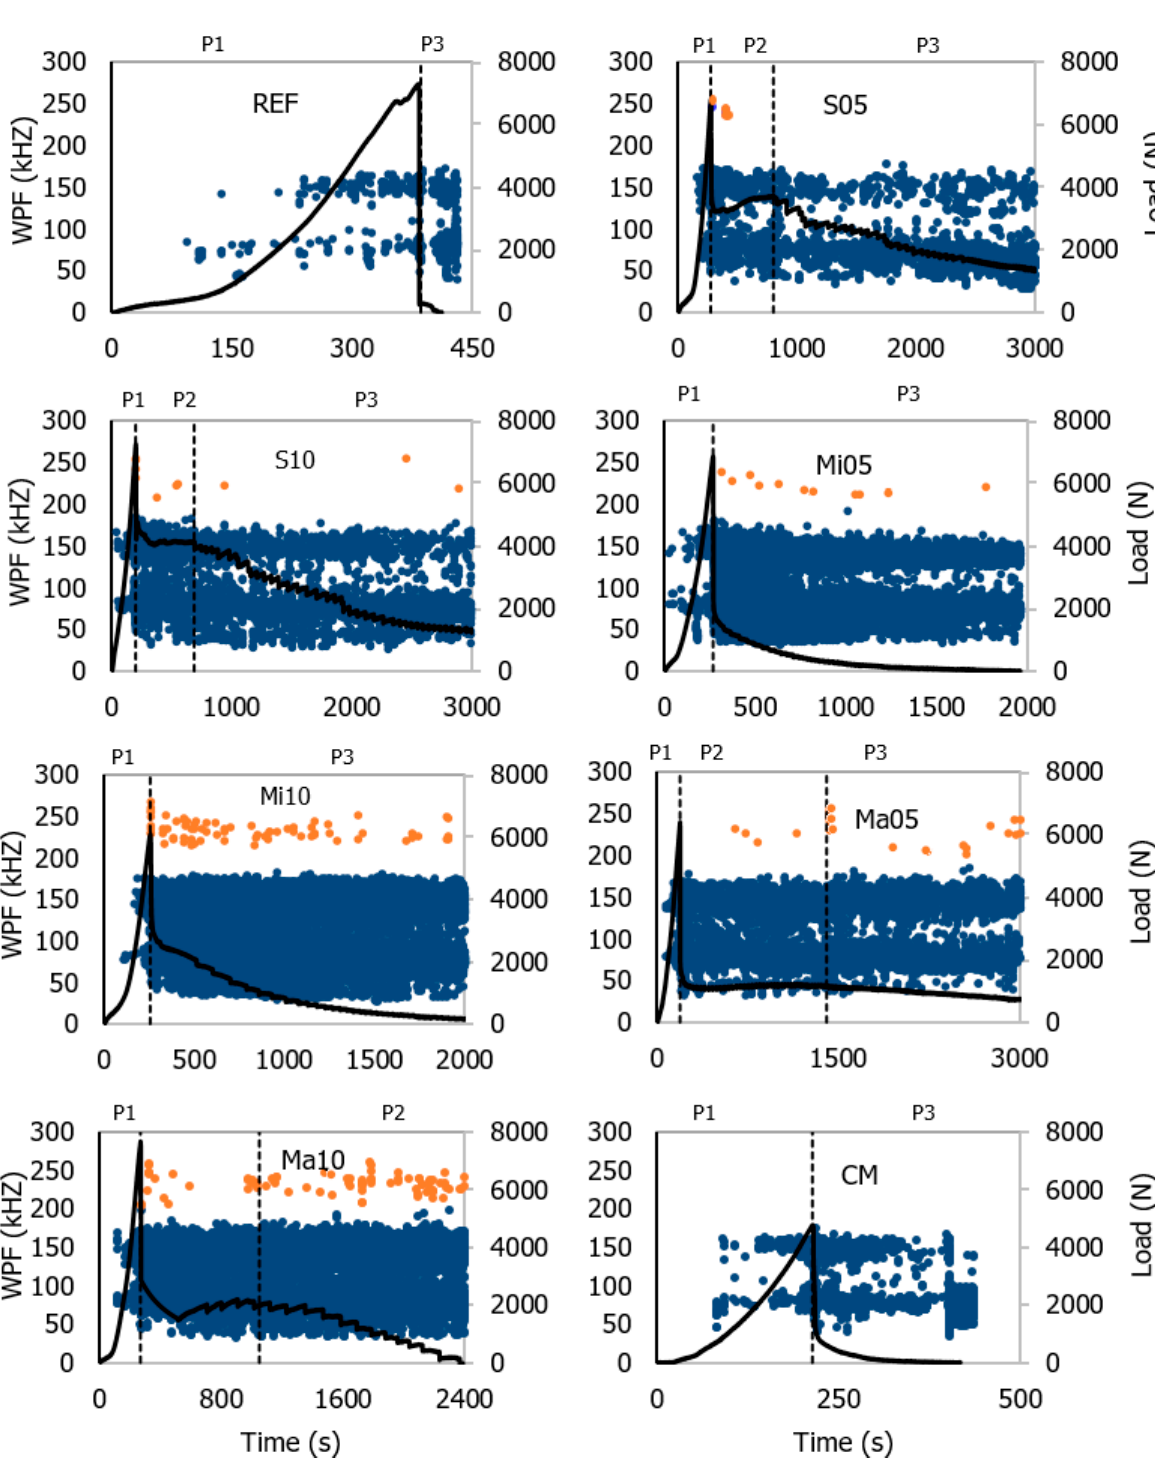
Figure 8. Origination time of clustered AE activities ( ● Cluster-1, ● Cluster-2).